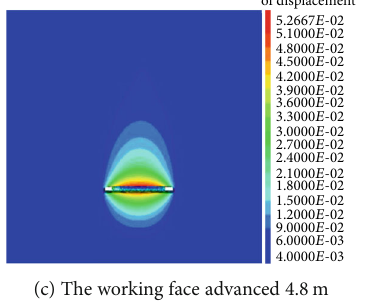
Figure 5: Top-coal displacement nephogram.